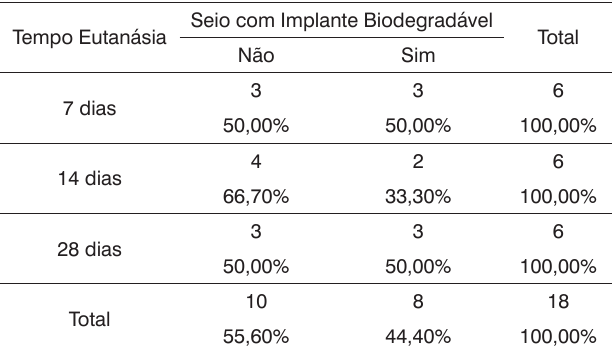
Tabela 6. Padrão inflamatório dos seios com implantes biode - gradáveis conforme o tempo de